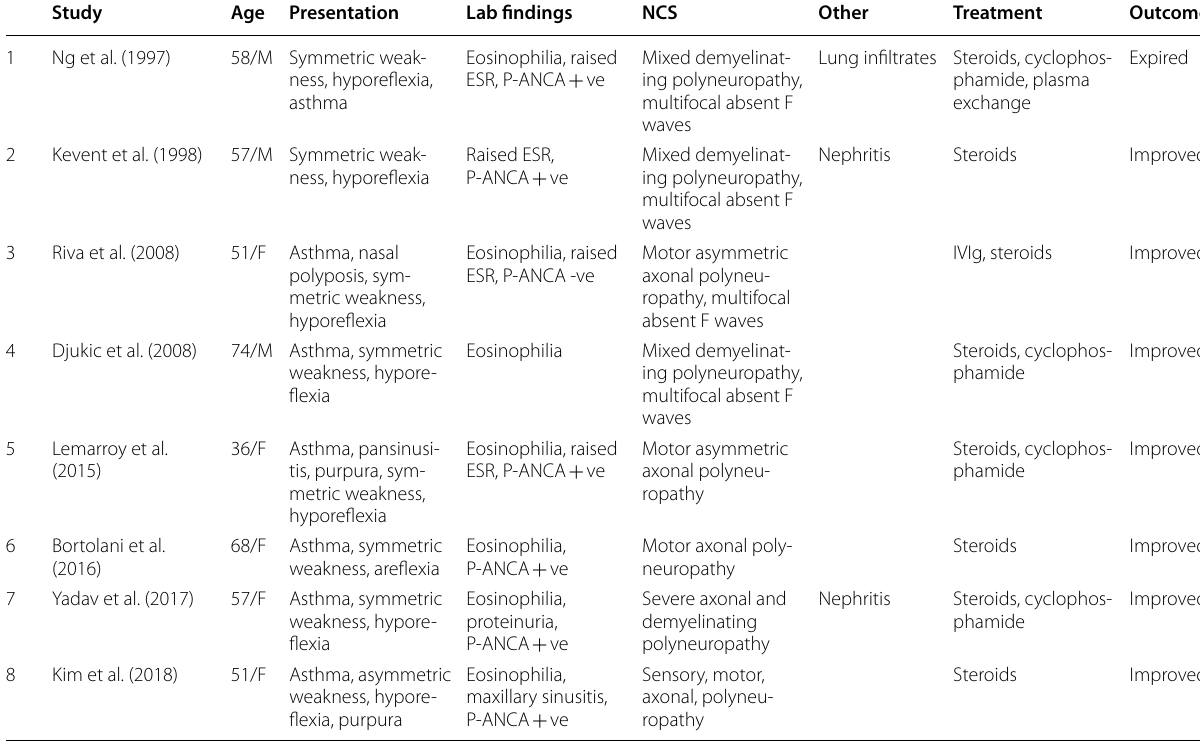
Table 1 Other studies with history of asthma, eosinophilia and no improvement after IVIg were the clues towards the vasculitic neuropathy, and it was supported by ANCA positivity in majority of cases